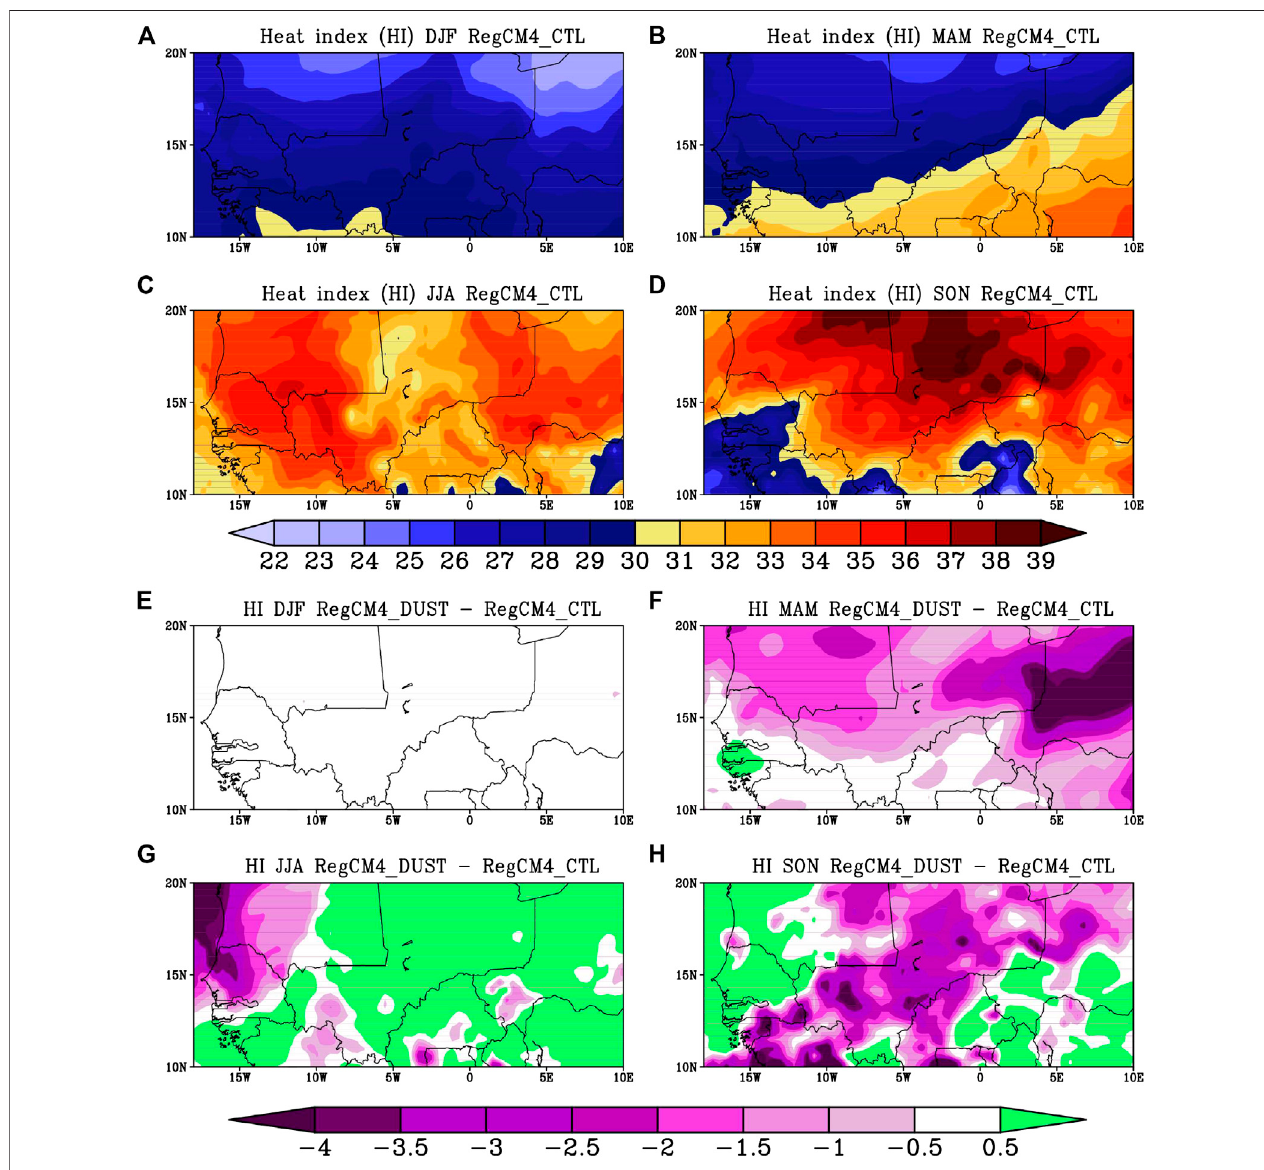
FIGURE 10 | Seasonal variability of the heat index ( ° C) averaged from 2001 to 2010 over the Sahel: (top) RegCM4_CTL, (down) difference between RegCM4_DUST and RegCM4_CTL. The differences are signi fi cant at 95% level using the Student test.